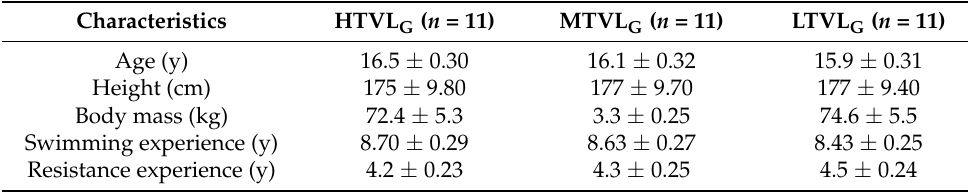
Table 1. Main characteristics of the competitive